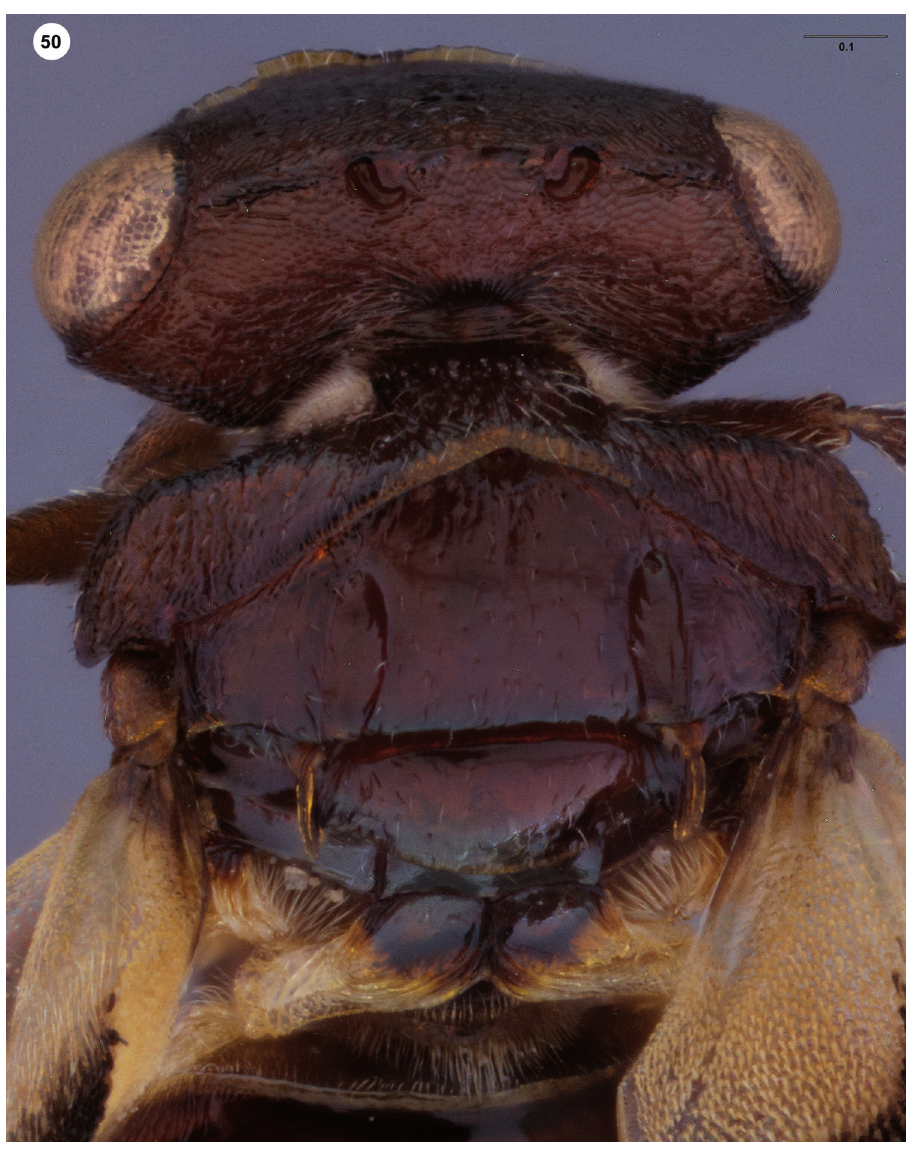
Figure 50. Pulchrisolia teras , female holotype (CASENT 2043862) 50 head, mesosoma, T1, T2, dorsal view. Scale bar in